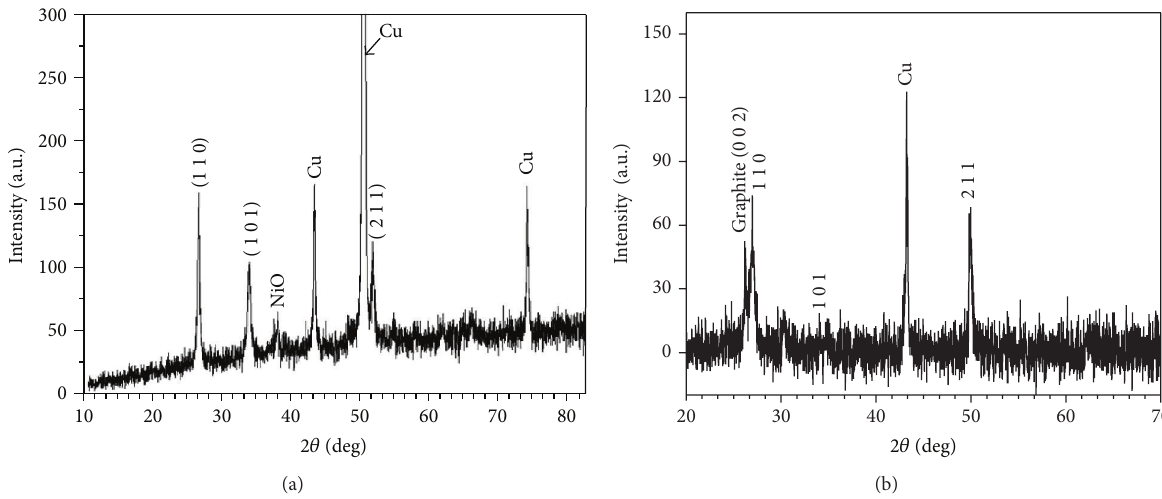
Figure 5: (a) X-ray diffractogram of Ni :SnO 2 catalyst dispersion. (b) SnO 2 -CNT composite films. ((a), (b)) The three peaks characteristic of tetragonal SnO 2 are presented as follows: (1 1 0), (1 0 1), and (2 1 1). (b) The CNT pattern is labeled as (0 0 2).